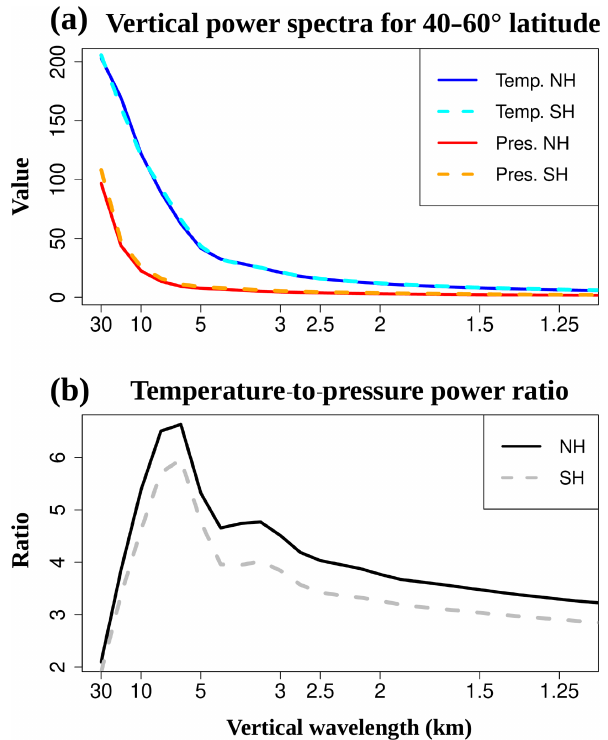
Figure 10. (a) Vertical power spectra of all RWP (w4–8) longitude– height snapshots between 40–60 ◦ latitude for both